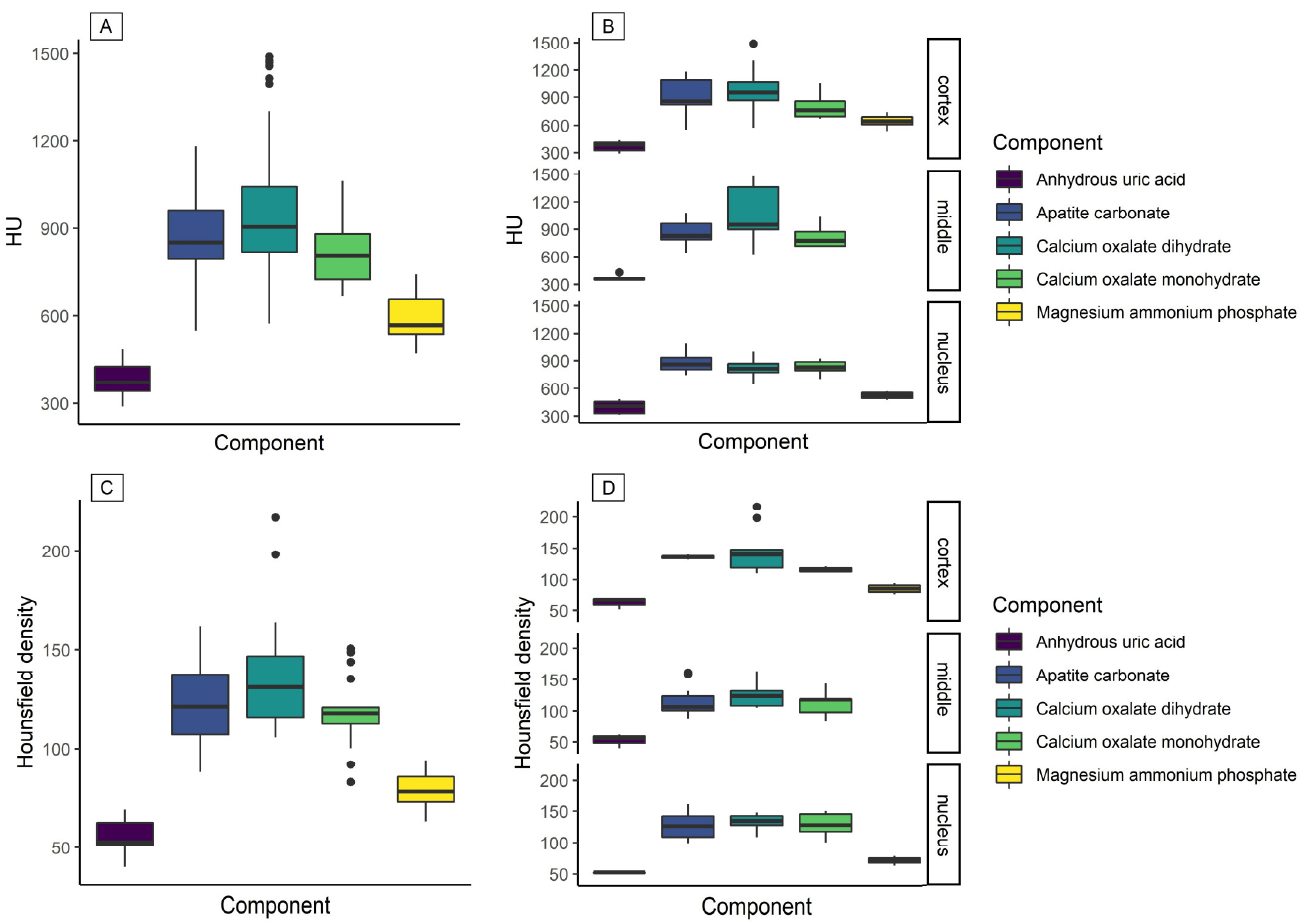
Figure 3. Distribution of stone composition in relation to HU values and Hounsfield density. ( A ) Distribution of HU for all components; ( B ) distributions of HU by sections; ( C ) distribution of Hounsfield density for each component; ( D ) distribution of Hounsfield density by section. Magnesium ammonium phosphate was not found in the middle section.